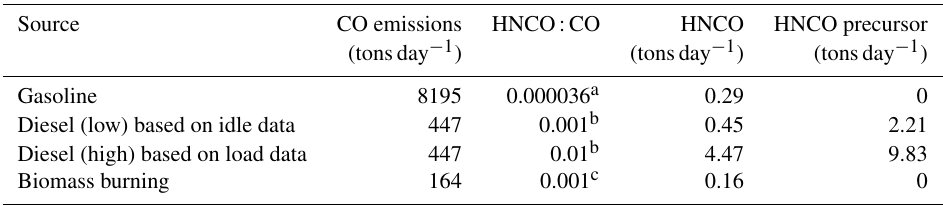
Table 1. Emissions and emission ratios for gasoline, diesel, and biomass burning sources for the state of California for an average summer day in 2005. Source CO emissions HNCO:CO HNCO HNCO precursor (tonsday − 1 ) (tonsday − 1 ) (tonsday − 1 ) Gasoline 8195 0.000036 a 0.29 Diesel (low) based on idle data 447 0.001 b 0.45 2.21 Diesel (high) based on load data 447 0.01 b 4.47 Biomass burning 164 0.001 c